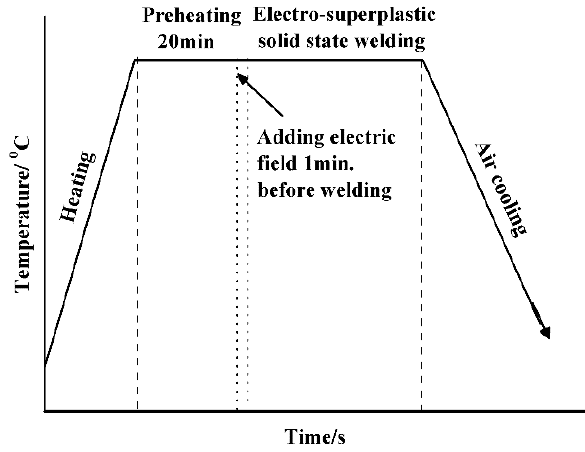
Figure 2. The process of electro ‐ superplastic solid state welding.